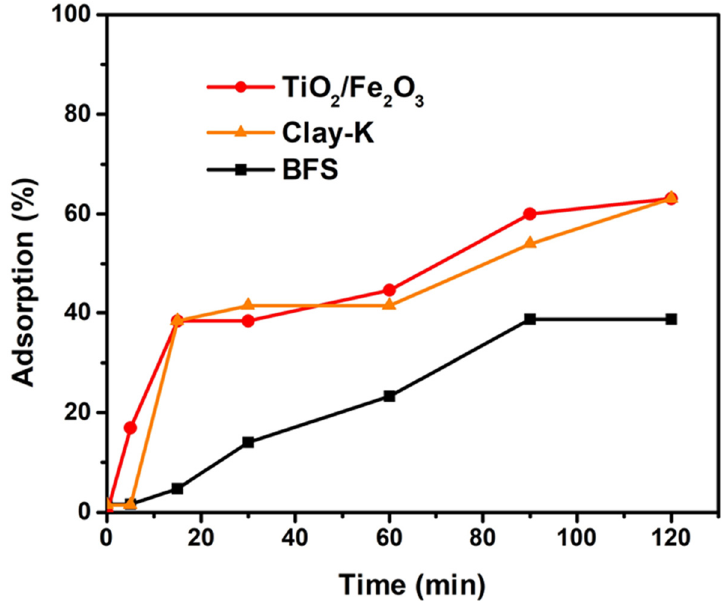
Figure 7. Cyanide adsorption kinetics in TiO 2 /Fe 2 O 3 , Clay-K, and BFS samples.